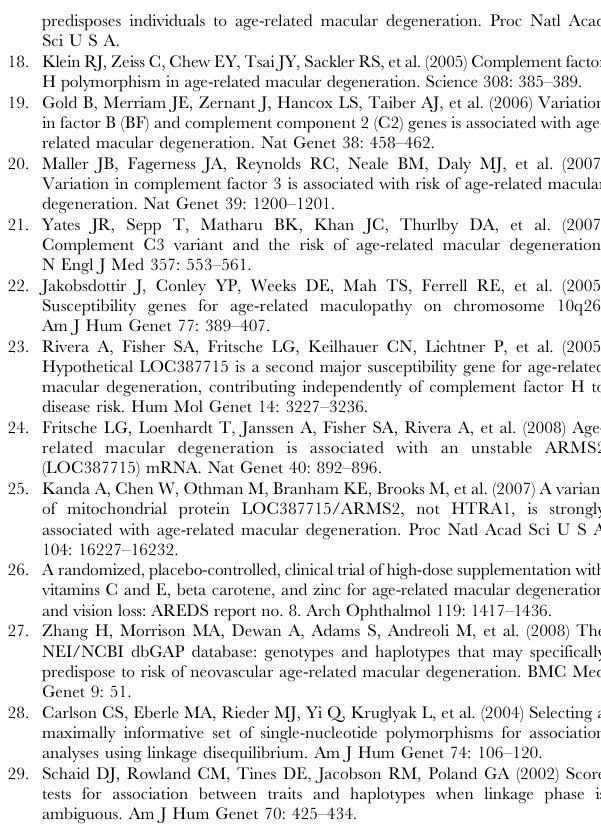
Table S3 Genotype distribution for all 300 SNPs genotyped on Mayo samples, which includes 57 AREDS SNPs, 225 tagSNPs, and 18 non-synonymous SNPs.